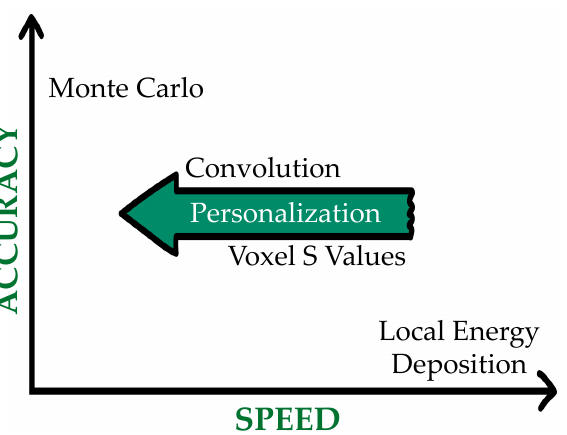
Figure 3. Dosimetric approaches in a figurative accuracy–speed plane. After MC, convolution with dose-point kernel (DPK) or voxel S-values (VSV) is in principle the most accurate method for dose calculation at the voxel level. A DPK represents the mean absorbed dose per transition (mGy/MBq/s) at a given radial distance from an isotropic point source located within a homogeneous, infinite medium (typically water). DPKs are continuous functions and in order to be used for voxel dosimetry they must be discretized and adapted to the voxel geometry. This could be done either considering source and target voxels as collapsed to the voxel centroid or as entire volumes. In this